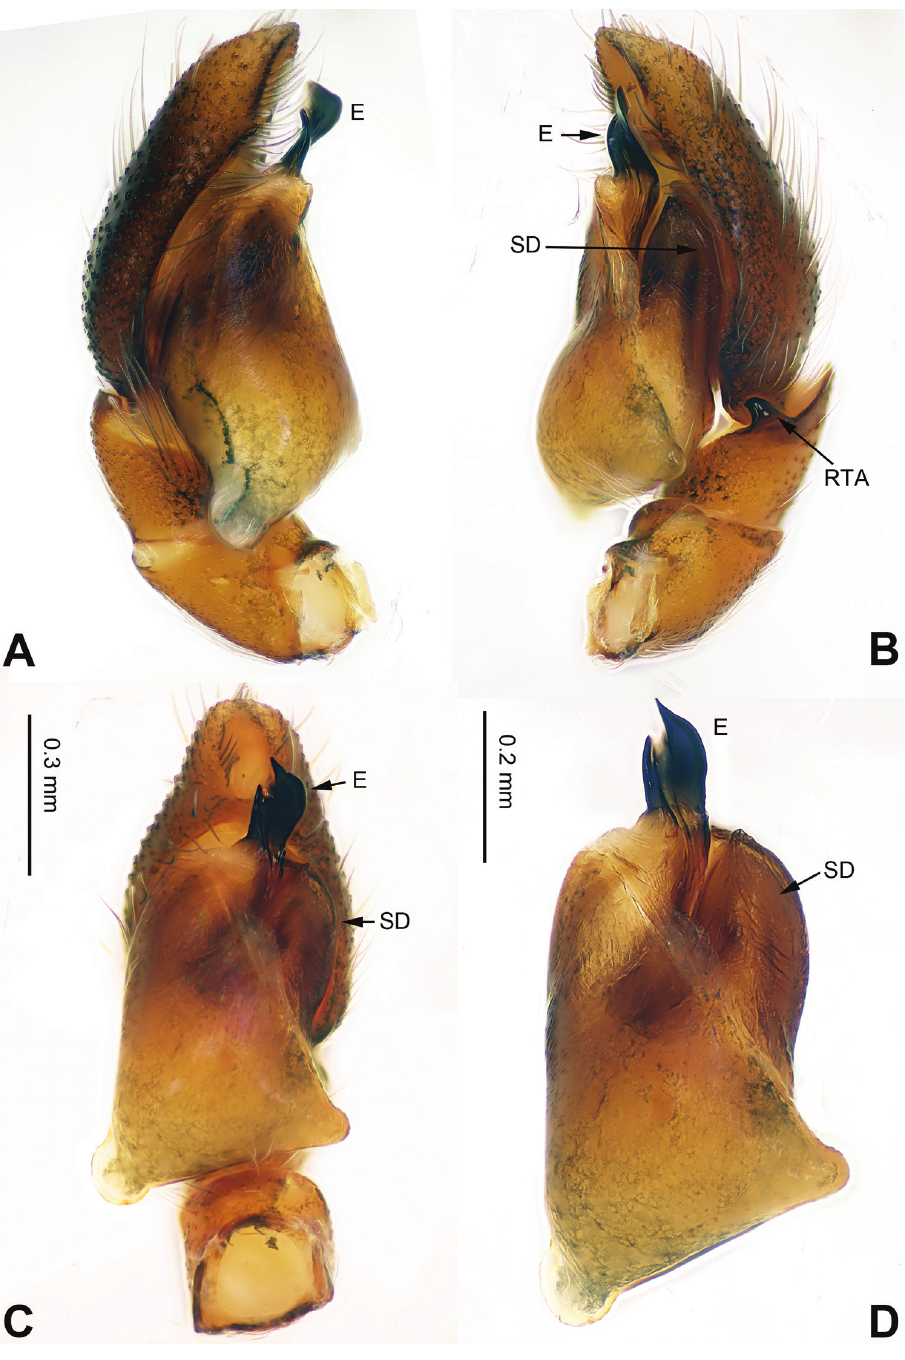
Figure 13. Palp of Chinattus wengnanensis sp. n., male holotype. A prolateral B retrolateral C ventral D bulb, ventral. Scale bar equal for A–C